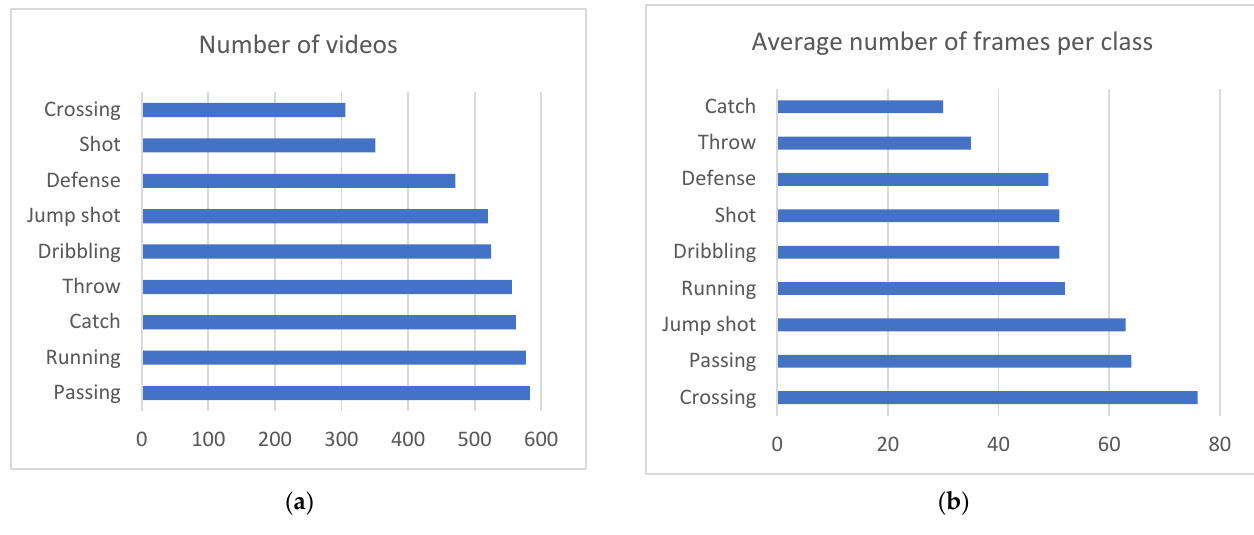
Figure 2. ( a ) Distribution of videos through classes, ( b ) Average number of frames in a sequence, per class.